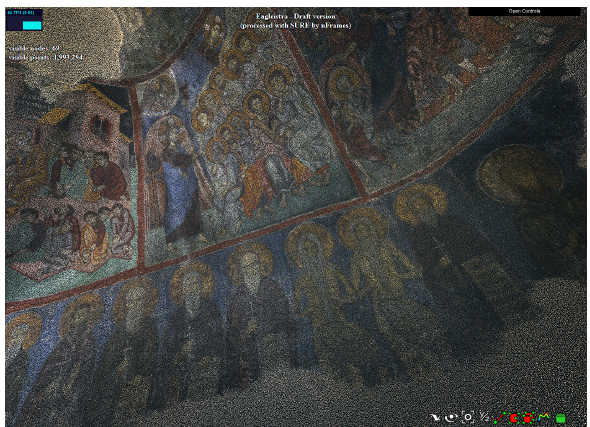
Figure 8: Potree Viewer of enkleistra Point Cloud